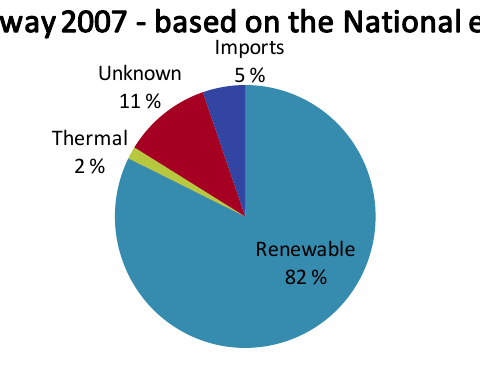
Figure 2. Present residual electricity mixes in Norway, Sweden and Finland (2007) [15]. (a) Residual electricity mix in Norway (2007). (b) Residual electricity mixes in Sweden and Finland